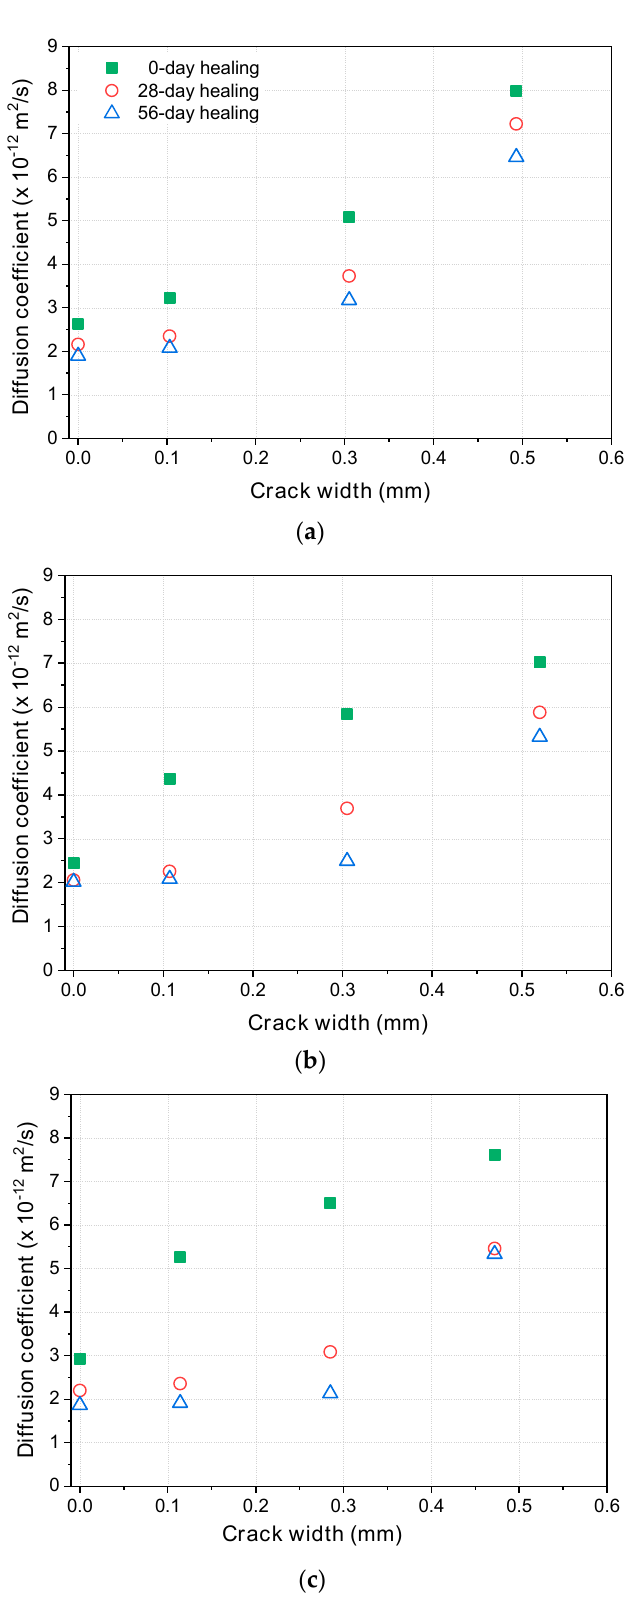
Figure 10. Relationship between diffusion coefficients and crack widths at different healing times: ( a ) OPC; ( b ) SH-A; ( c ) SH-B.